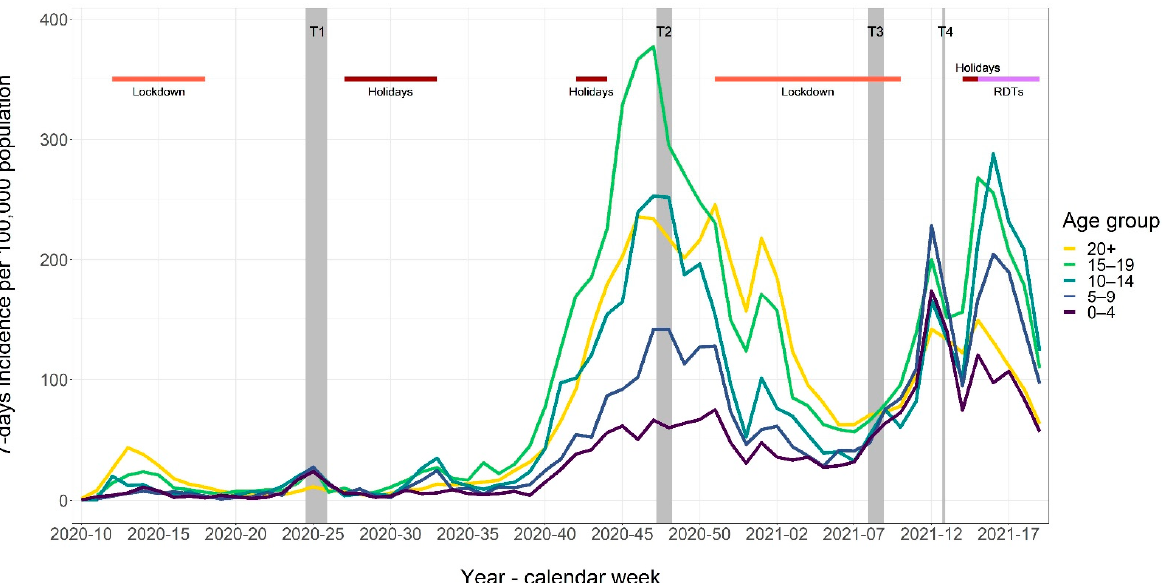
Figure 1. Community incidence of SARS-CoV-2 infection rates in Berlin, June 2020–March 2021, as well as observation periods (grey-shaded columns) and school holidays and closure periods (red bars).